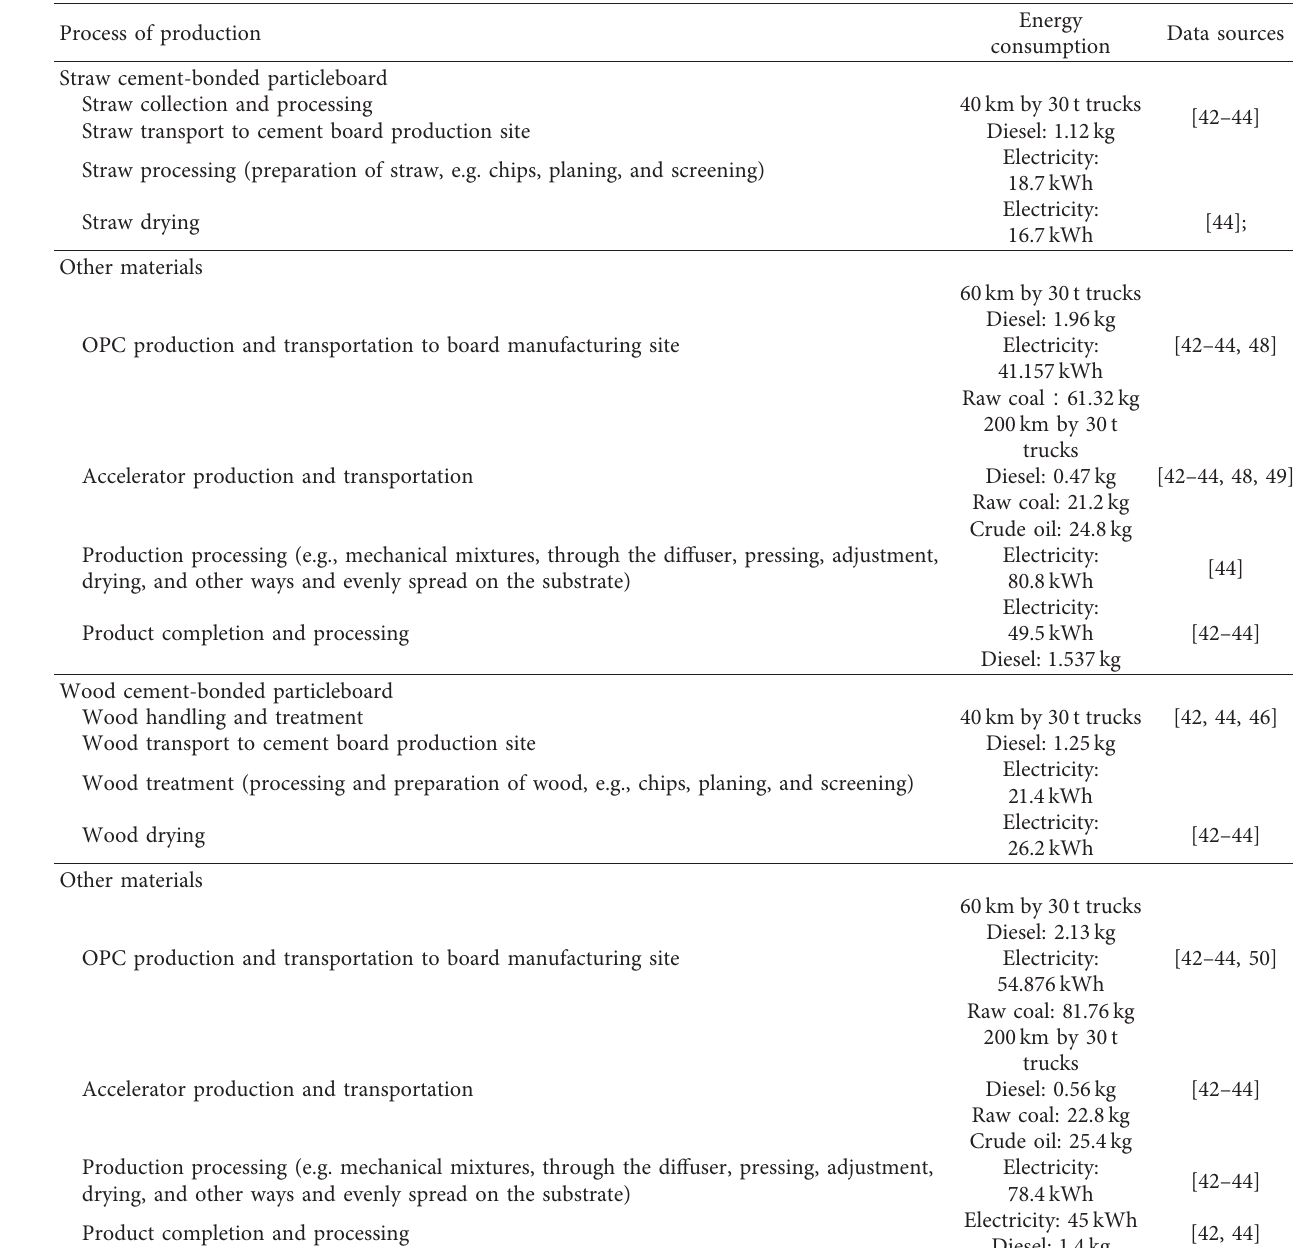
Table 4: LCI data for production of 1m 3 straw cement-bonded particleboard and wood cement-bonded particleboard.